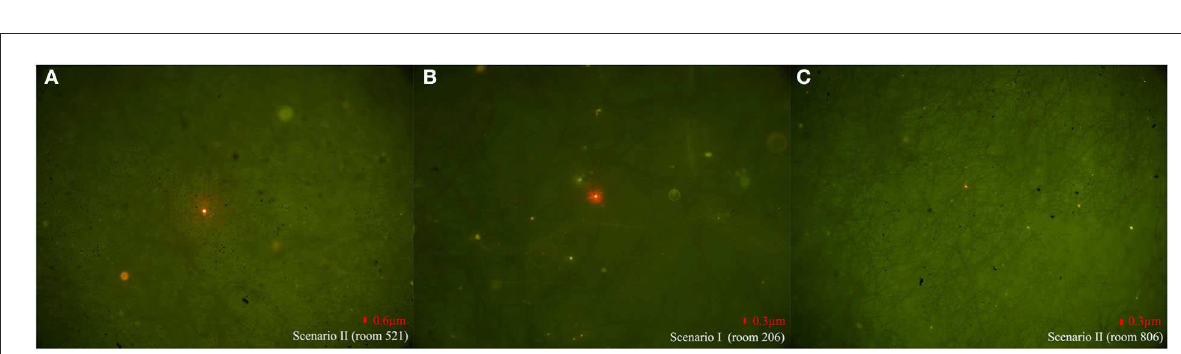
FIGURE3 Representative photos of fluorescent microspheres tracked by different sampling methods in different rooms in two scenarios. (A) Fluorescent microspheres were observed on aerosol filter membrane samples in Scenario II of building A. (B) Fluorescent microspheres were observed on aerosol filter membrane samples in Scenario I of building B. (C) Fluorescent microspheres were observed on smear swab samples collected from the floor drain in Scenario II of building